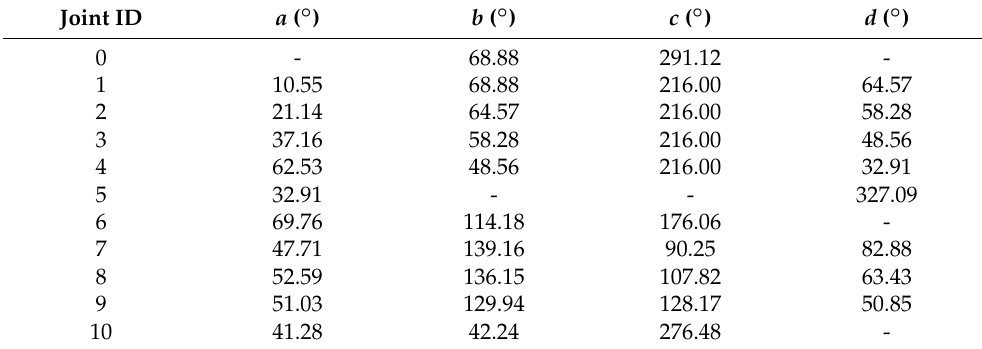
Table 2. The dataset of the joint angles for the case study